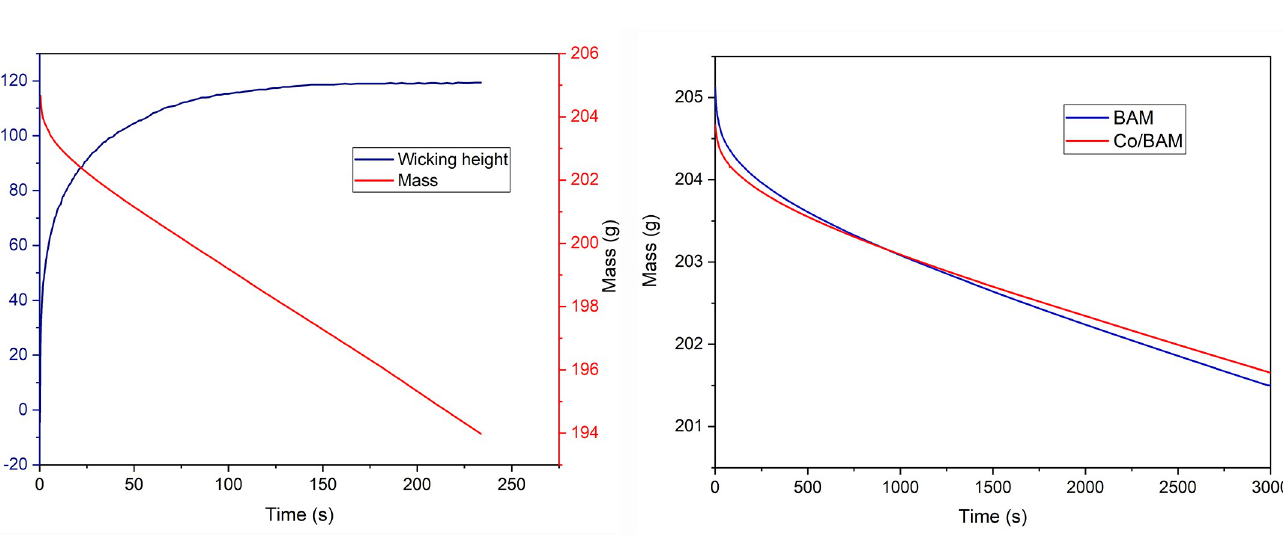
PLOS ONE | https://doi.org/10.1371/journal.pone.0241665 November16,